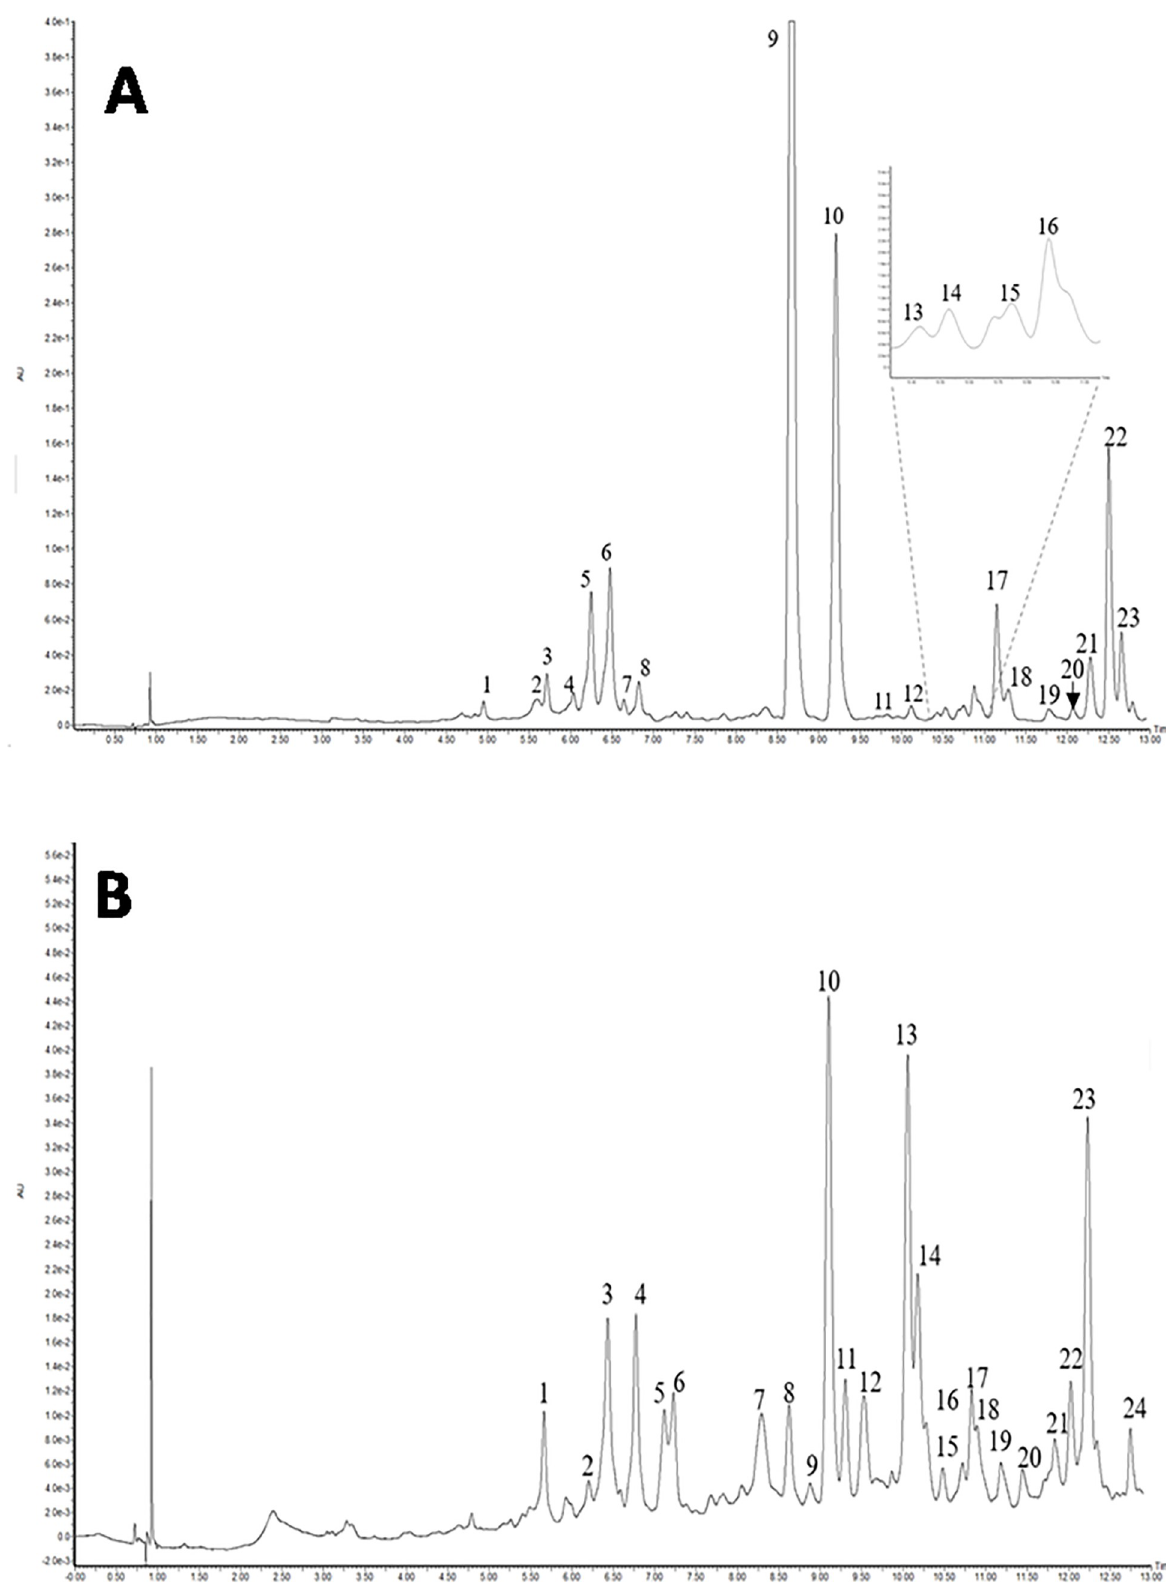
Fig 7. UPLC chromatograms of D . pulvinatus (A) and R . squarrosus (B) at 280 nm.